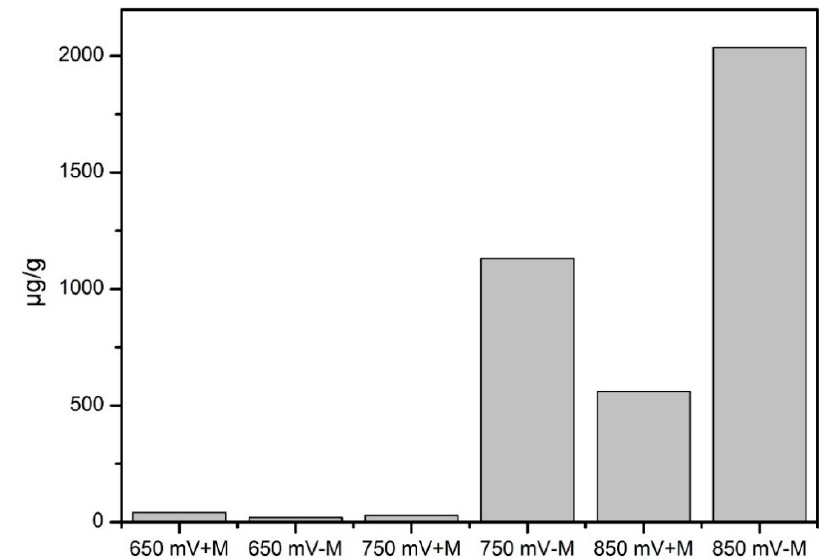
Figure 7. The concentration of elemental sulfur on pyrite under different redox potentials and microbial conditions.